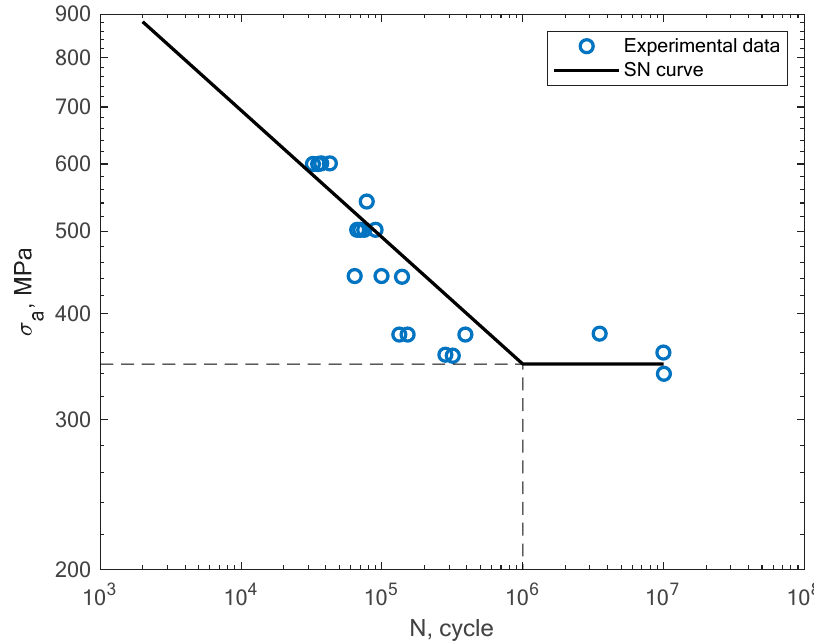
Figure 15. S–N curve for the experimental tension–compression (R = − 1) fatigue test results reported by Damon et al. [17] under the conditions of room temperature and a horizontal direction of the printing orientation.